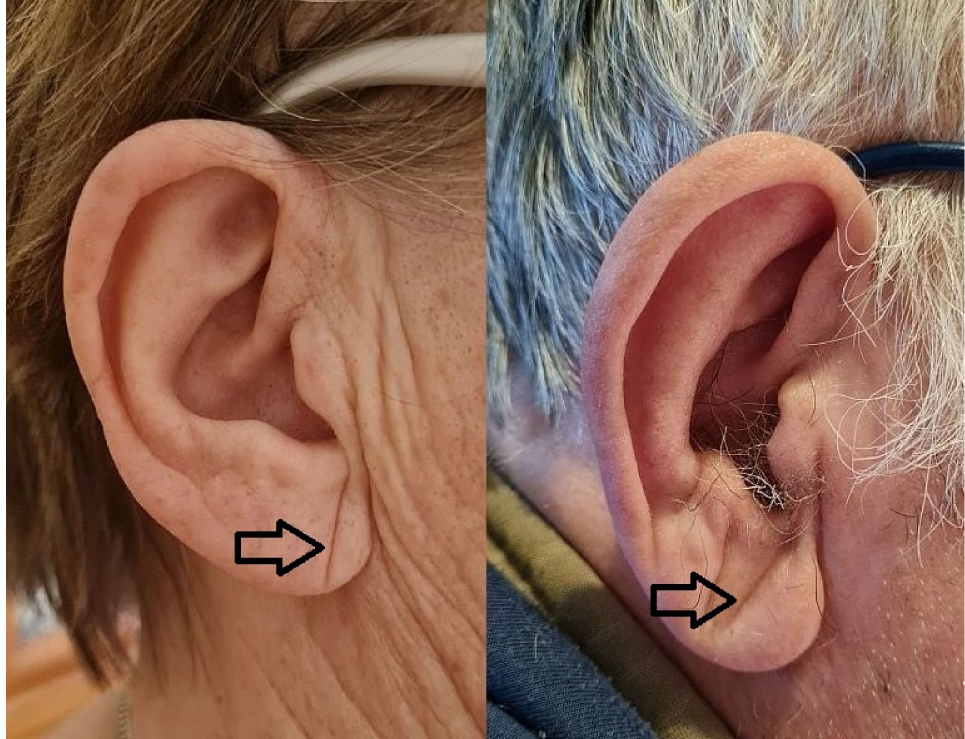
Figure 1. Diagonal earlobe crease in a woman without coronary artery disease and a man with coronary artery